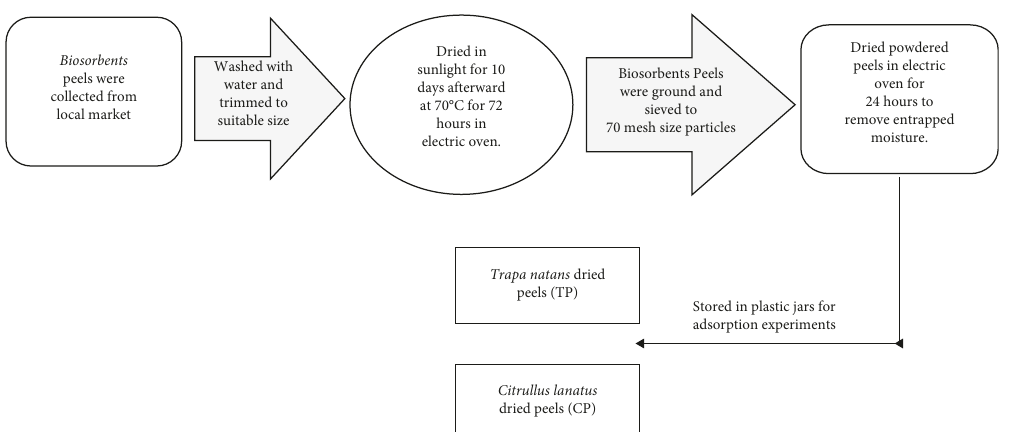
Figure 1: Schematic diagrams for the preparation of raw adsorbents.